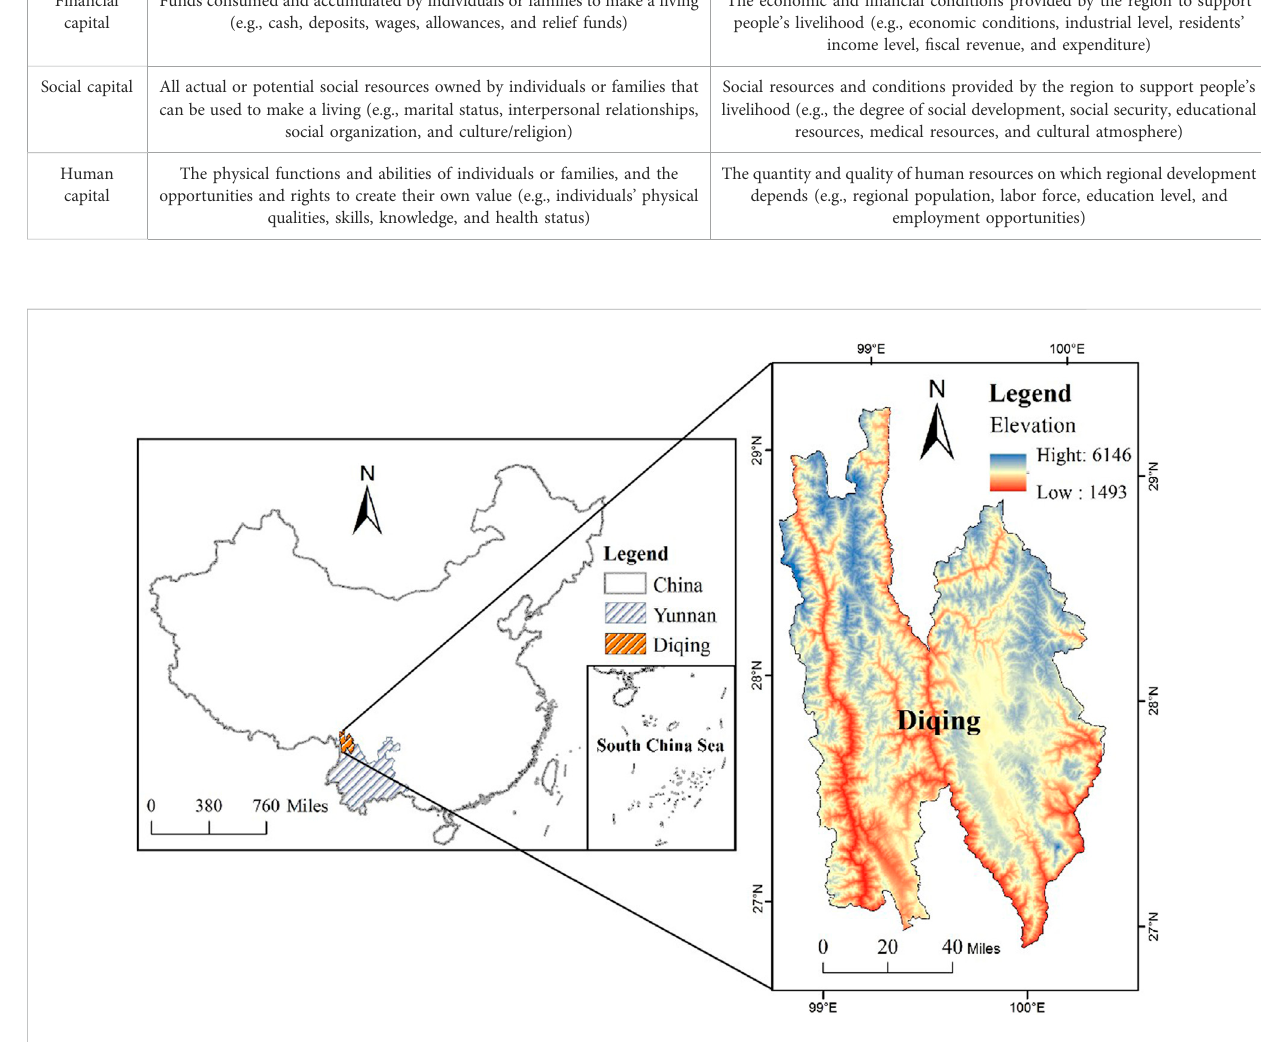
FIGURE 3 Map of Diqing in Southwest